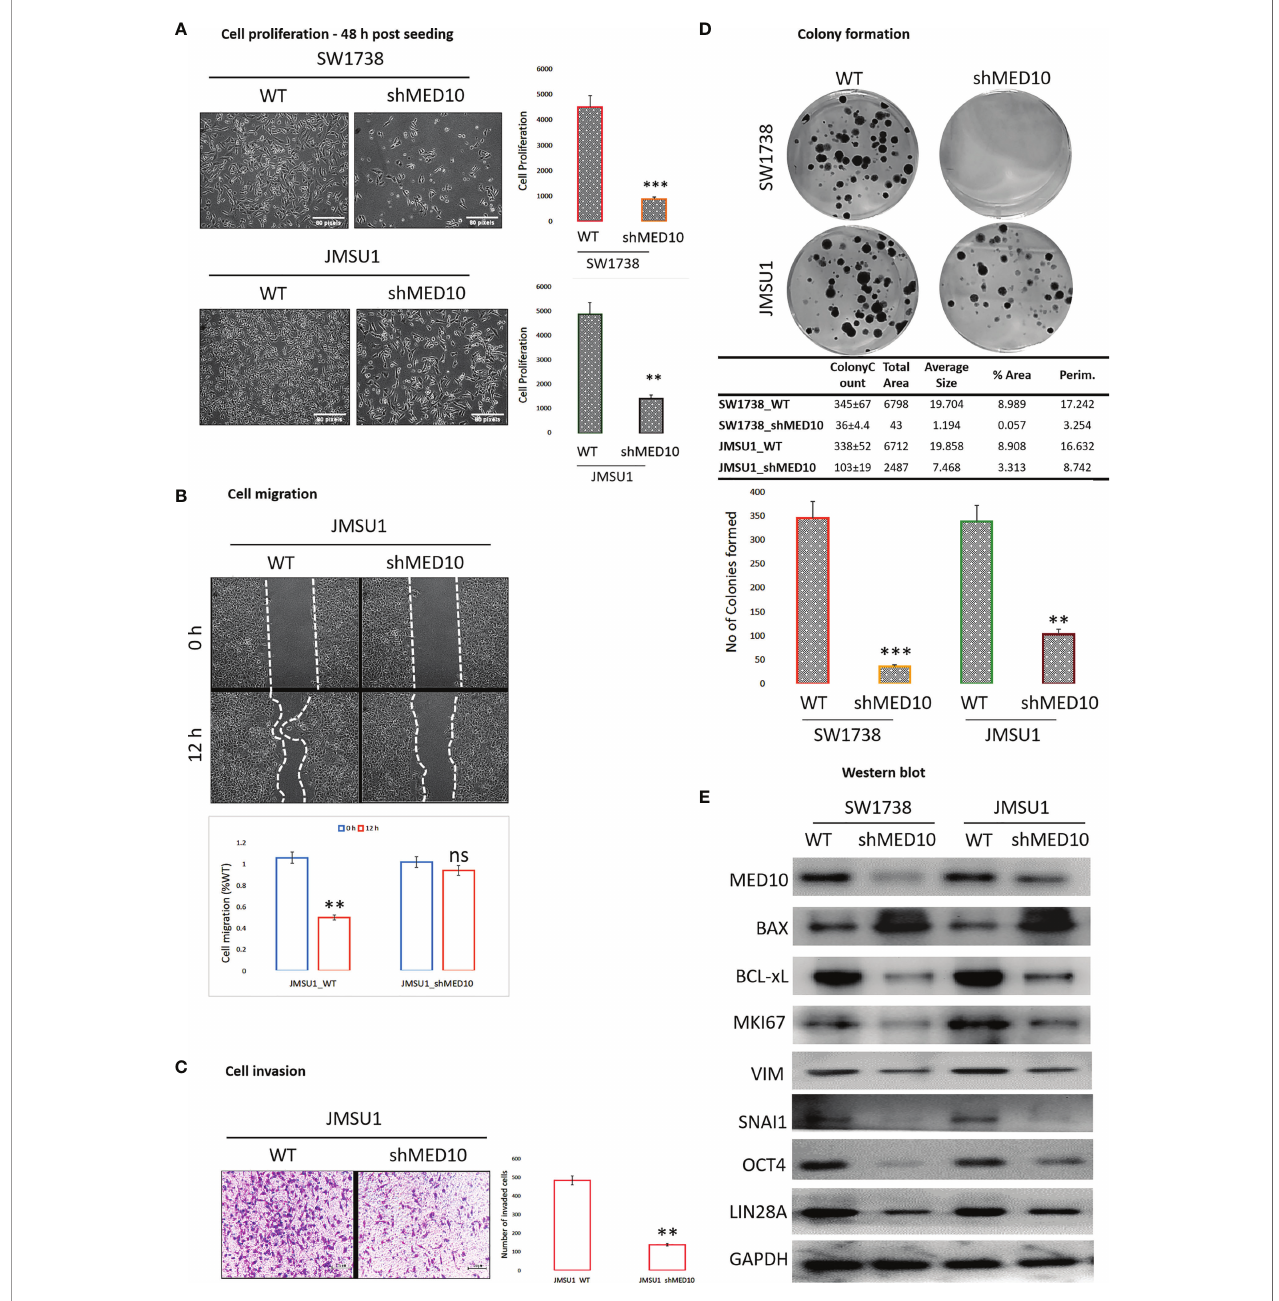
FIGURE 6 | shRNA-mediated targeting of MED10 in bladder urothelial carcinoma cells signi fi cantly attenuate their oncogenicity and metastatic phenotype. Photomicrographs and histograms showing the effect of knocking down MED10 on the (A) proliferation, ( B ) migration, (C) invasion, and (D) colony formation of SW1738 and JMSU1 cells. (E) Representative Western blot images showing the effect of shMED10 on the expression of MED10, BAX, BCL-xL, VIM, SNAI1, OCT4, or LIN28A protein expression level in SW1738 and JMSU1 cells. GAPDH serve as loading control. ns, not signi fi cant; **p < 0.01; ***p <